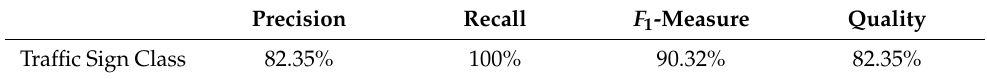
Figure 8. Extracted traffic sign candidates and their classification labels for four sections of the road. Table 1. Summary of traffic sign detection results in terms of four